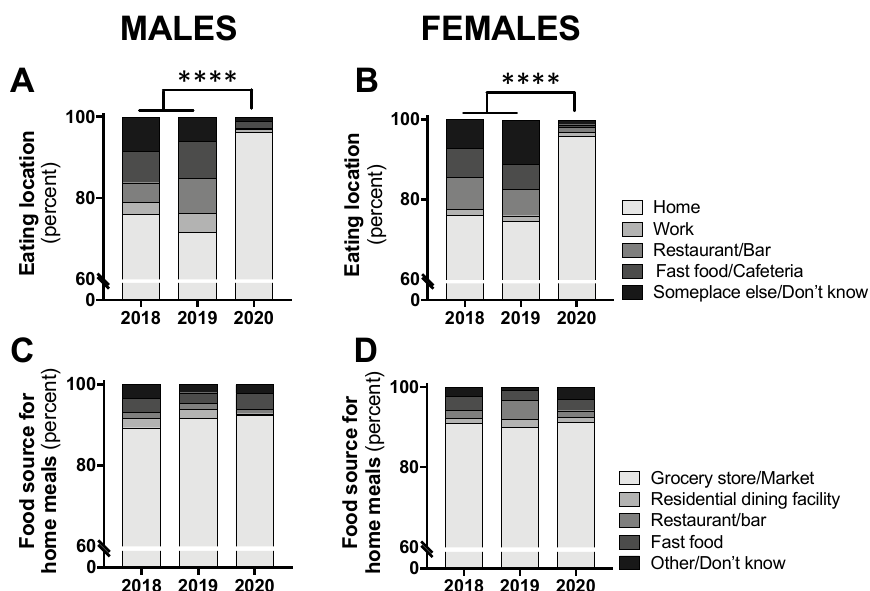
Figure 3. Eating location ( A , B ) and food source for all eating occasions at home ( C , D ) in male and female students in class year 2020 ( n = 66 males, 83 females) compared with 2018 ( n = 61 males, 97 females) and 2019 ( n = 73 males, 104 females). Data are presented as the proportion of students included in this analysis each year. No statistical differences were observed between 2018 and 2019 and, therefore, these years were combined for statistical comparisons with 2020. **** p < 0.0001 between 2020 and 2018/2019 for “home” vs. all other locations by chi-square test.